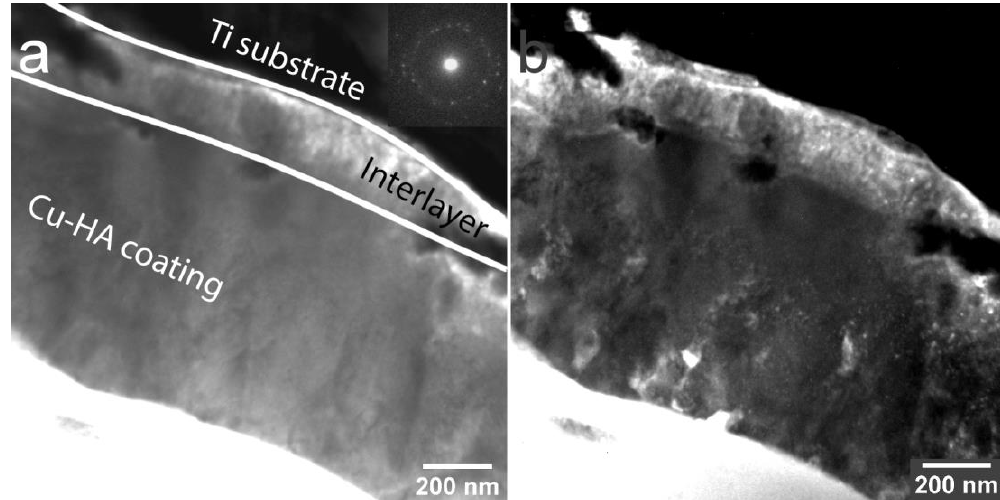
Figure 7. TEM image of the cross-section of Cu-HA coating on Ti after HT at 700 °C BF, the inset shows the corresponding electron diffraction pattern ( a ) and DF ( b ).